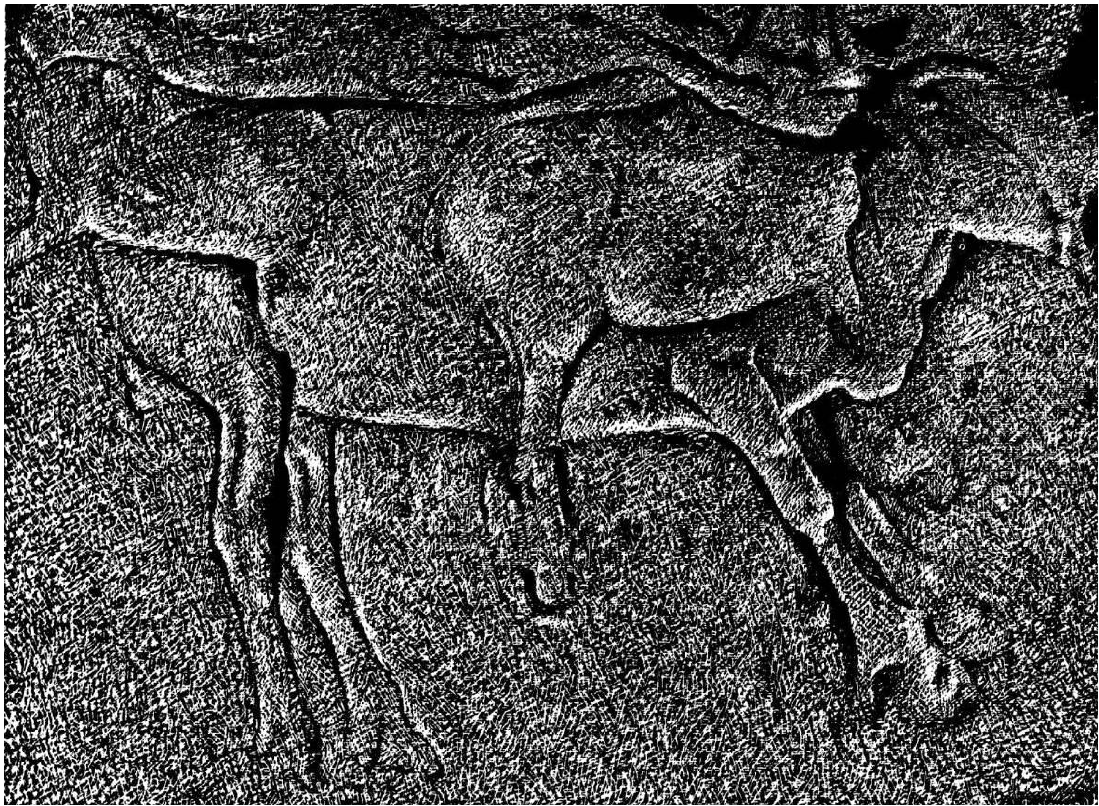
Figure 5. Cast of the wall sculptures of the Isturitz cave (Passemard, 1918)